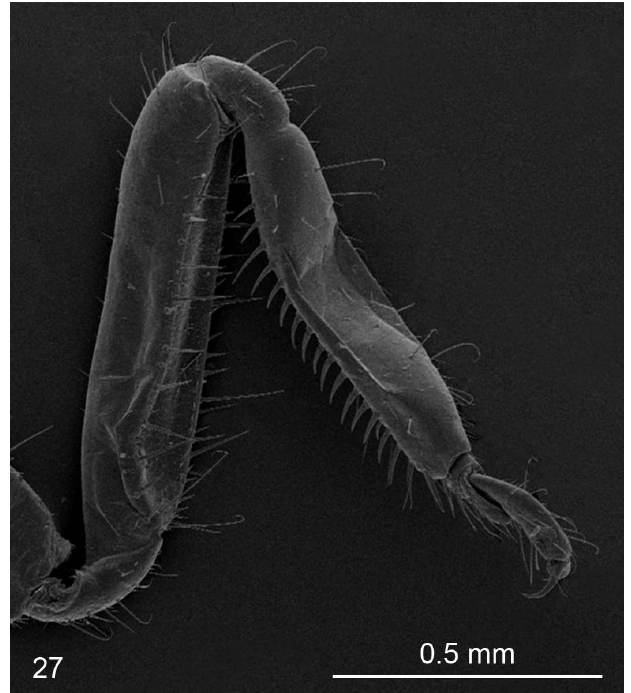
Fig 27. Worker leg of Apicotermitinae sp., one of two rows of tick bristles on